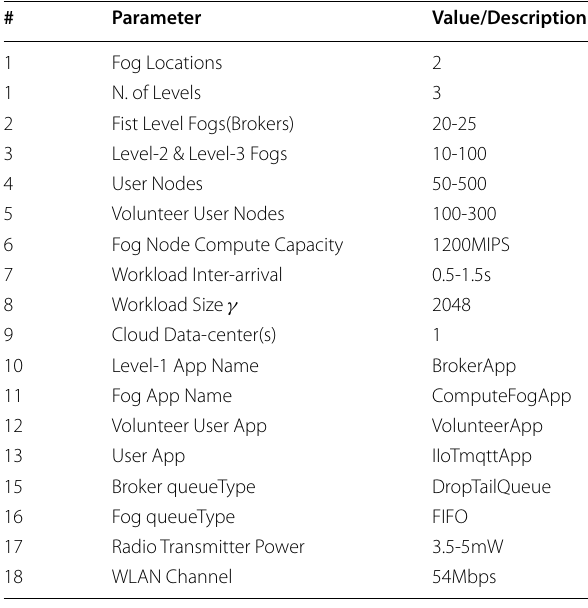
Table 3 Simulation parameters